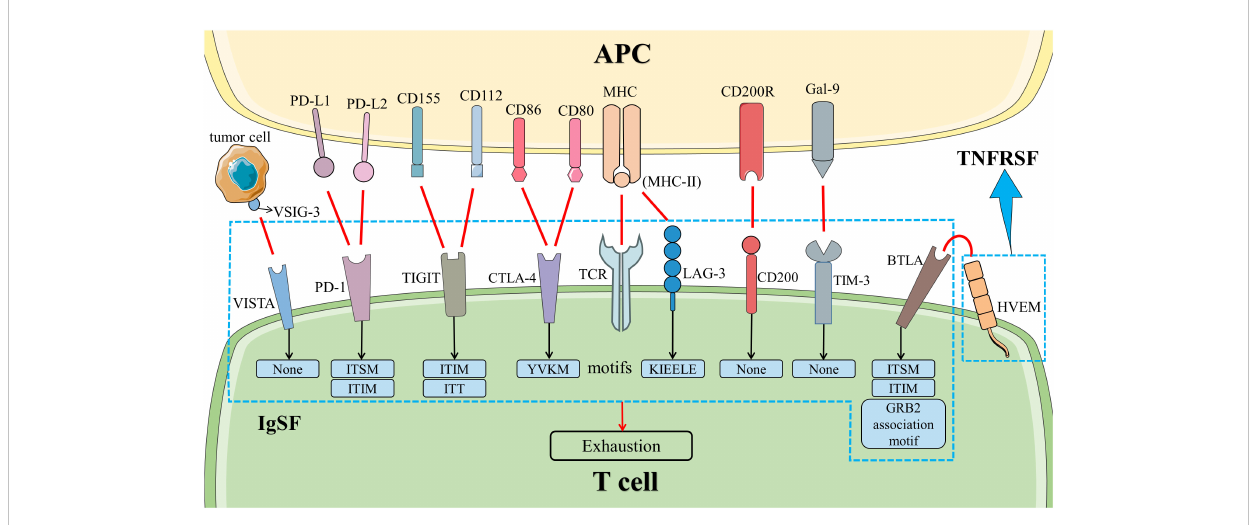
FIGURE 3 Co-inhibitory signal pathways in T cells. The co-inhibitory signal pathways induced the exhaustion of T cells. HVEM is a member of TNFRSF. Other molecules belong to IgSF. Except for LAG-3, VISTA, TIM-3, and CD200, all of them have inhibitory signal motifs in the cytoplasmic tail. LAG-3 has a unique KIEELE motif whose role is unclear, while VISTA, TIM-3, and CD200 do not have any motifs in the cytoplasmic tail. Abbreviation: APC, antigen-presenting cell; BTLA, B and T lymphocyte attenuator; CTLA-4, cytotoxic T lymphocyte-associated molecule 4; Gal-9, galactin-9; HVEM, herpesvirus entry mediator; IgSF, immunoglobulin superfamily; LAG-3, lymphocyte activation gene 3; MHC, major histocompatibility complex; PD-1, programmed cell death 1; PD-L1, programmed death ligand 1; TCR, T cell receptor; TIGIT, T ‐ cell immunoglobulin and ITIM domain; TIM-3, T cell immunoglobulin and mucin domain-containing protein 3; TNFRSF, tumor necrosis factor receptor superfamily; VISTA, V-domain immunoglobulin suppressor of T cell activation; VSIG-3, V-set and immunoglobulin domain containing 3.